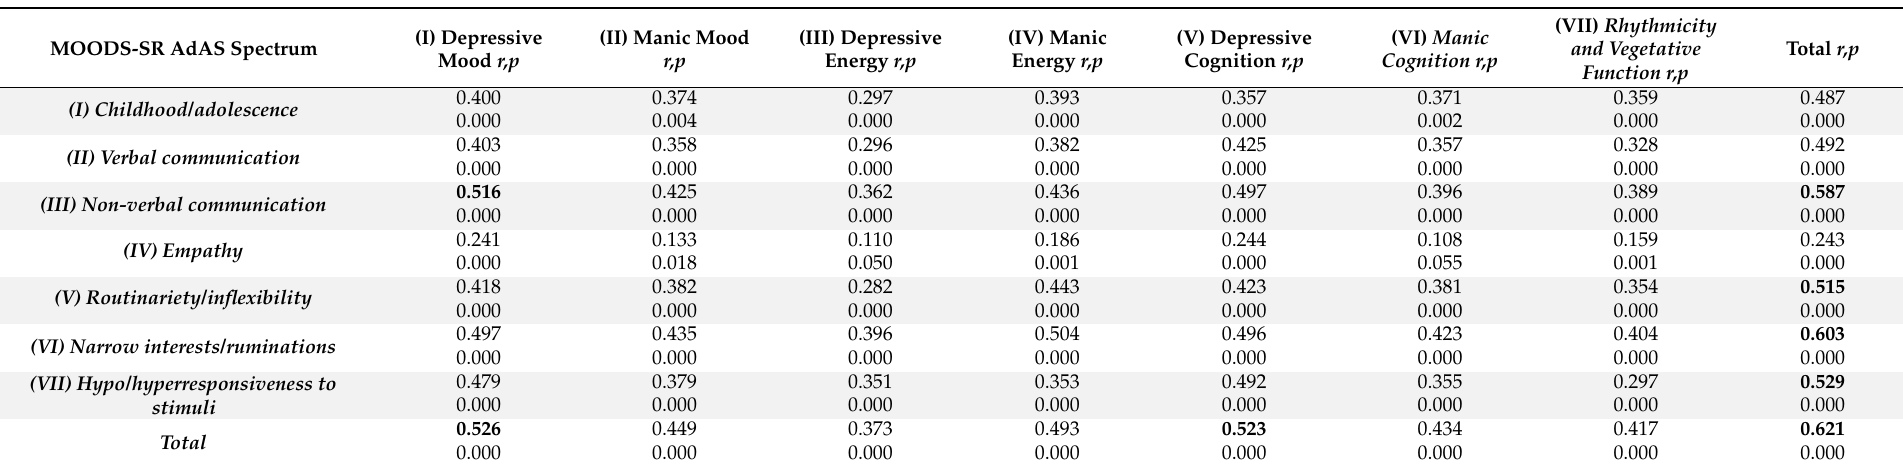
Table 3. Correlation between AdAS spectrum and MOODS-SR total and single domain scores in the total sample (N =